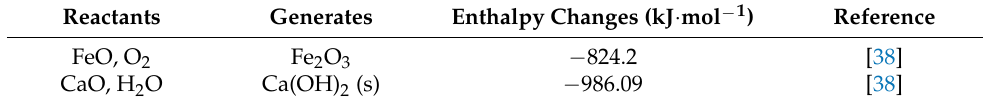
Table 4. Exothermic reaction.